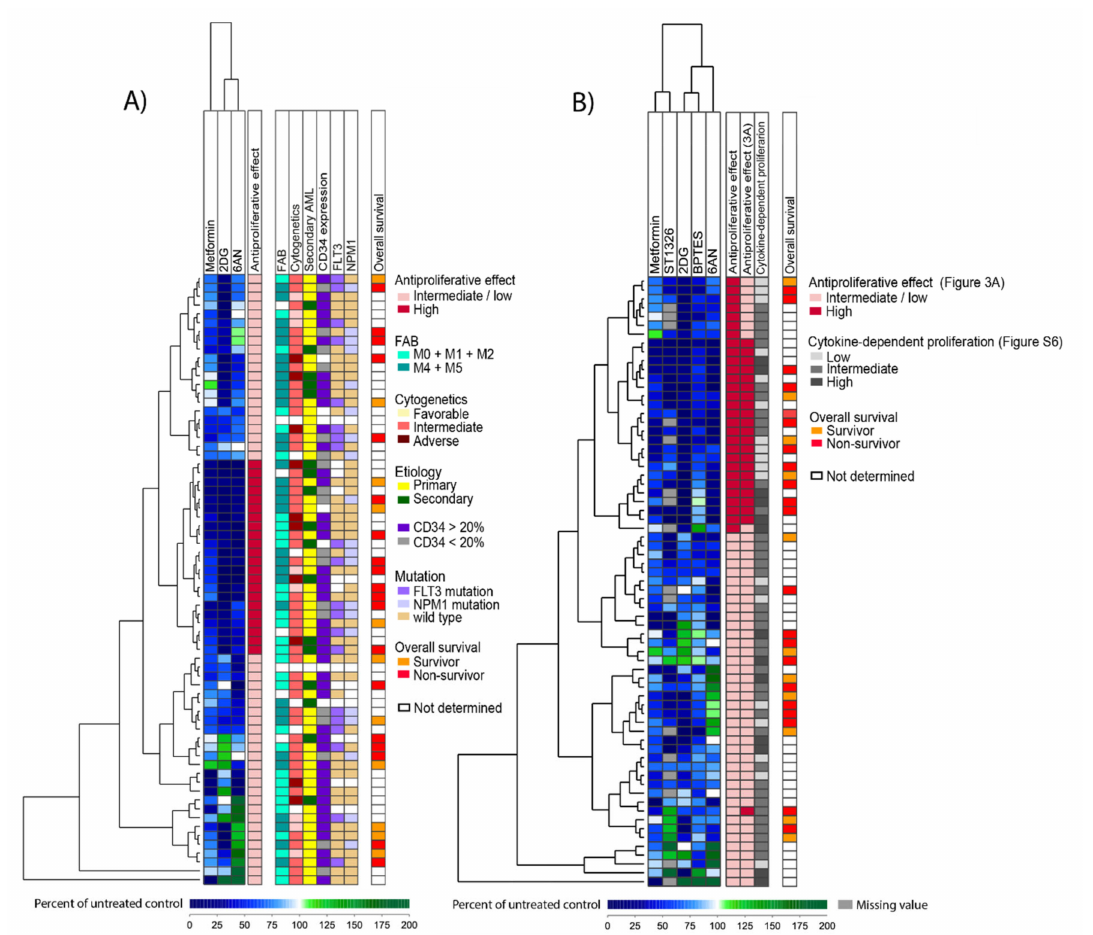
Figure 3. Unsupervised hierarchical cluster analysis based on the e ff ects of metabolic inhibitors on proliferation of primary human AML cells. Primary AML cells were grown in medium supplemented with cytokines and treated with metformin 2.5 mM, 2DG 0.6 mM, 6AN 100 µ M, BPTES 20 µ M, ST1326 50 µ M, lonidamine 300 µ M and AZD3965 200 nM or medium alone (untreated controls) for 7 days before cell proliferation was analyzed using the [ 3 H]-thymidine incorporation assay. The percent proliferation (i.e., proliferation in treated cultures relative to untreated controls) was estimated for each patient / inhibitor combination and patient subclusters are shown on the left side of each analysis. ( A ) Clustering based on e ff ects of metabolic inhibitors that can influence glucose metabolism. The cluster analysis was based on the e ff ects of metformin, 2DG and 6AN on AML cell proliferation and identified a subset of 22 patients with overall higher sensitivity towards these metabolic inhibitors (illustrated as dark red in the first column to the right). The next columns to the right indicate biological and clinical characteristics for each individual patient (FAB, cytogenetics, etiology, CD34 expression, FLT3 -ITD and NPM1 mutations, overall survival). ( B ) Clustering based on significant antiproliferative e ff ects of metabolic inhibitors on AML cells. The cluster is based on the results for the five inhibitors that showed significant antiproliferative e ff ects on AML cells when analyzing the overall results (see Figure 1). Two main patient subsets were then identified, the upper cluster included 29 patients (shown as dark red in the first column to the right) and showed stronger antiproliferative e ff ects after inhibitor treatment, while the lower cluster included 40 patients (light red). Columns also visualize patient subsets identified in other cluster analyses, that is e ff ects on proliferation after treatment with inhibitors influencing glucose metabolism (cluster data from Figure 3A) and e ff ects on proliferation after treatment with all seven metabolic inhibitors (data from Figure S6) and overall